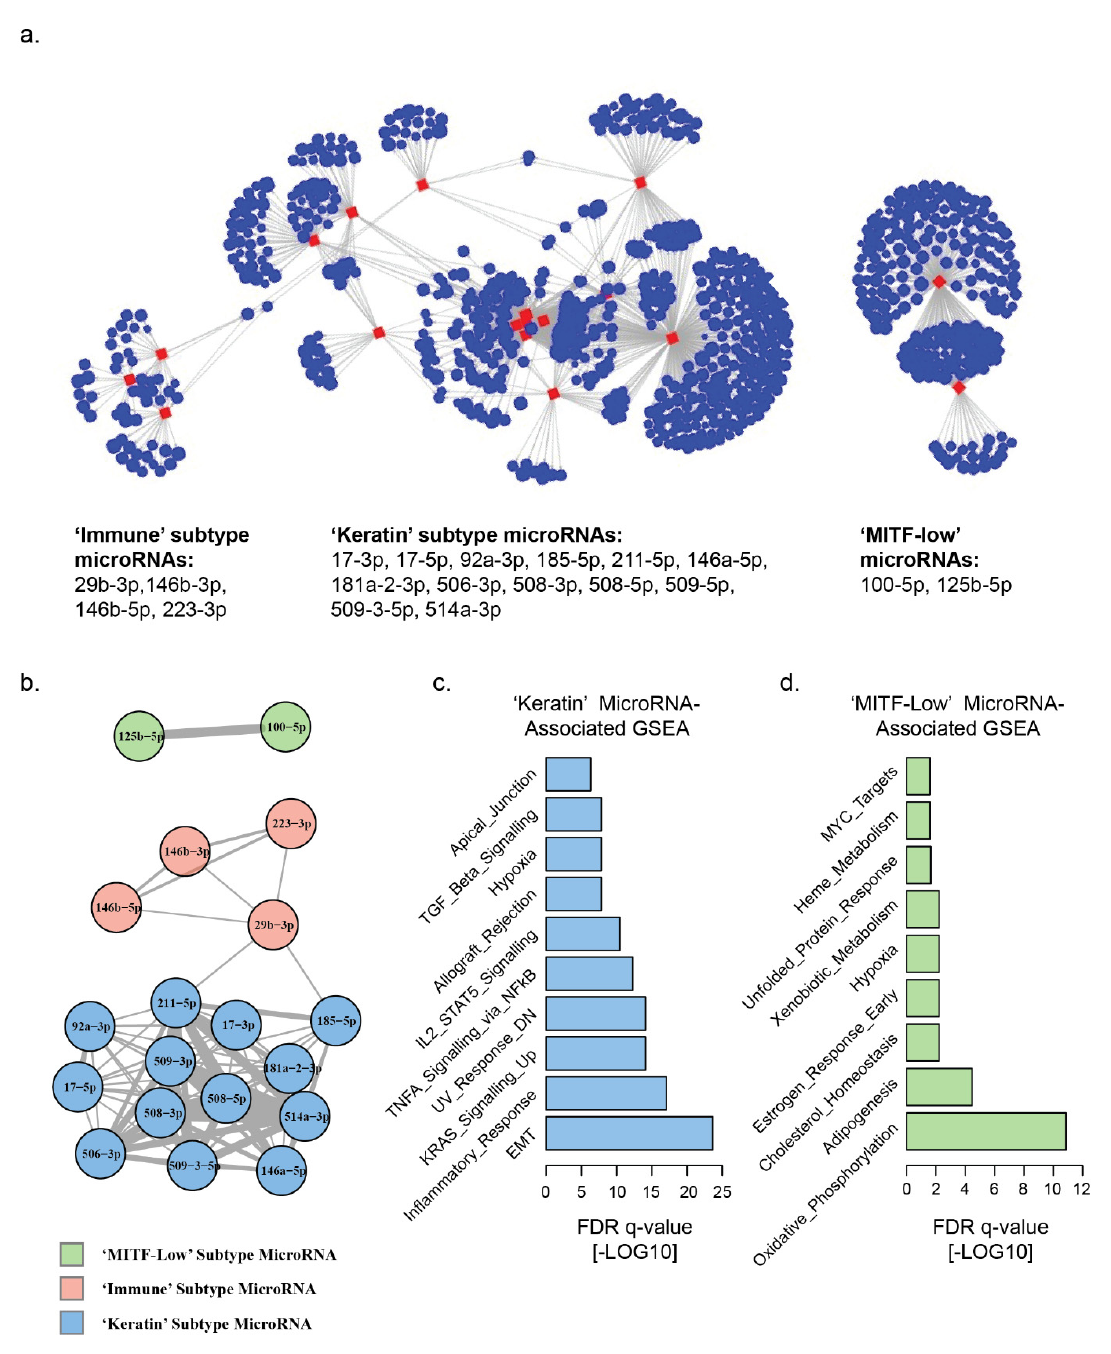
Figure 1. Network analysis of global microRNA–mRNA associations in TCGA melanoma. Inverse correlations of microRNA and mRNA pairs were calculated to identify potential microRNA-regulated gene networks. ( a ) Bipartite network projection based on the 19 microRNAs (red) with the highest numbers (>20) of inversely correlated (Spearman’s rho < − 0.4) mRNAs (blue) within all TCGA melanoma samples, identifies three distinct microRNA–mRNA network hubs. ( b ) Unipartite network projection displaying the mRNA inverse correlations shared by each microRNA (a higher number of correlations is indicated by connecting line thickness). MicroRNAs are color coded by their previous association with specific TCGA transcriptomic subsets. ( c ) Gene-set enrichment analysis of all mRNAs inversely correlated with ‘keratin’ transcriptomic- subset-associated microRNAs. ( d ) Gene-set enrichment analysis of all mRNAs inversely correlated with ‘MITF-low’ transcriptomic-subset-associated